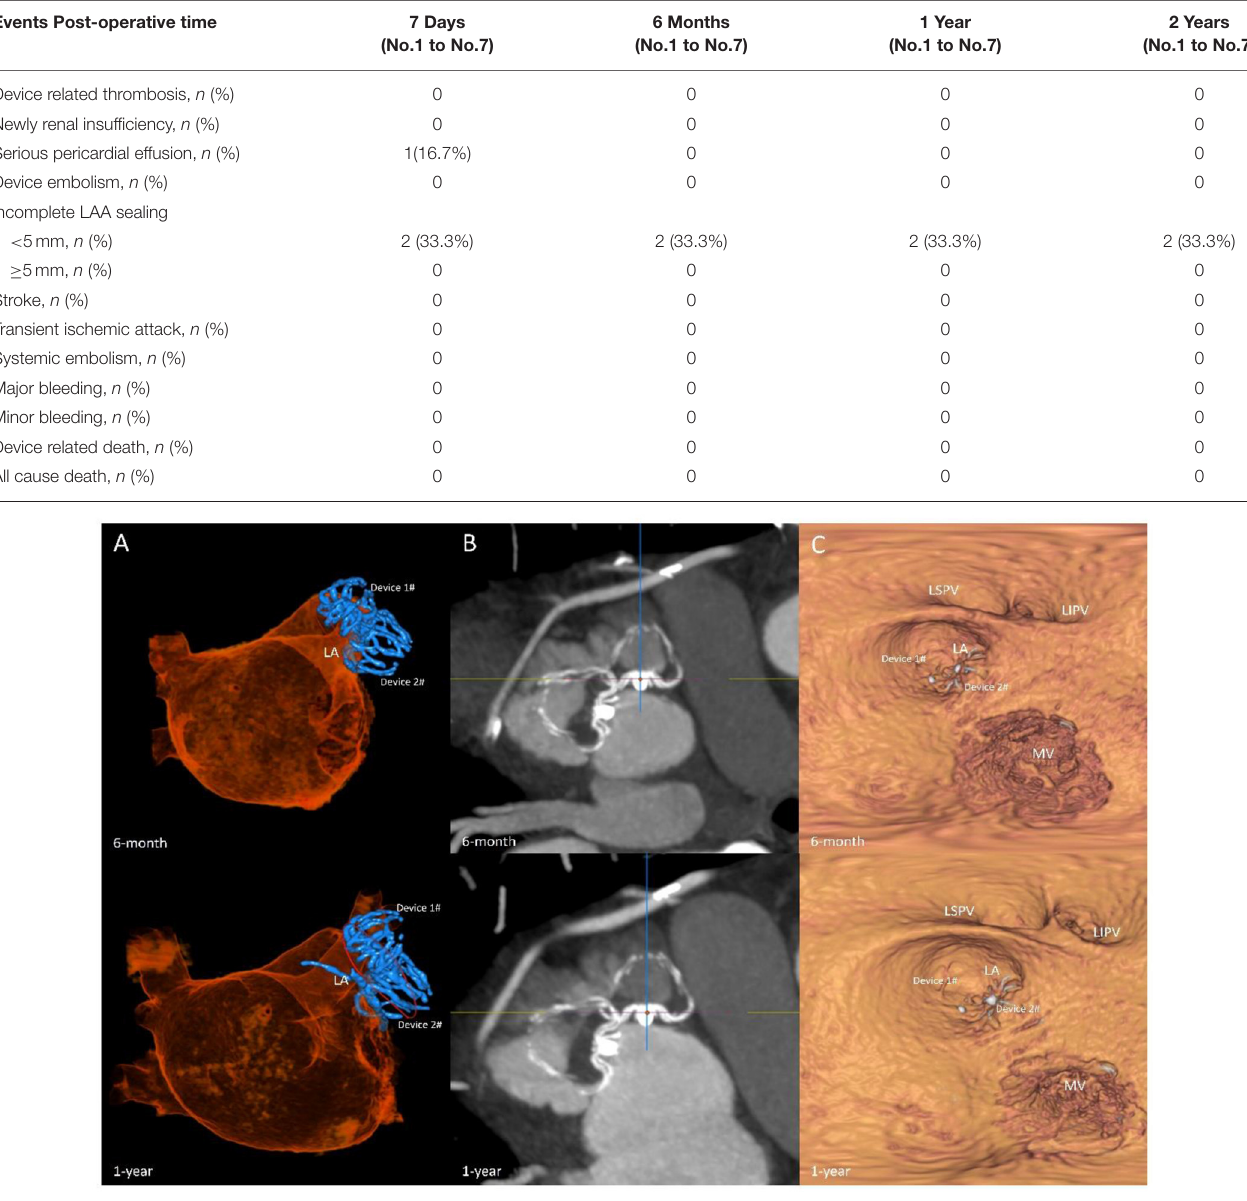
TABLE 2 | Major adverse events within 2-year follow-up after the procedures. Events Post-operative time 7 Days